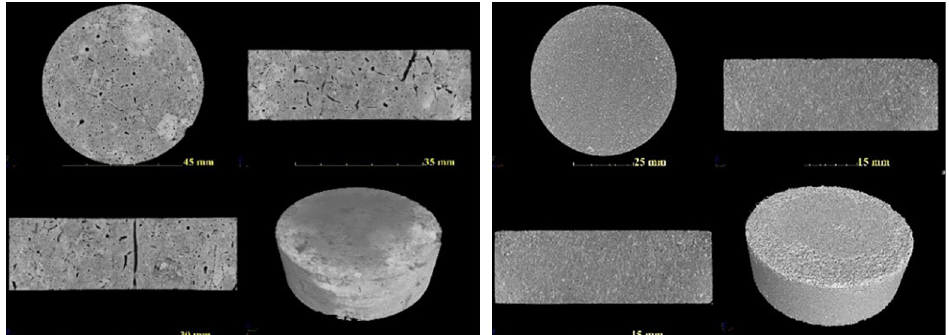
Fig 20. Three views and three-dimensional reconstruction of the ring cutter specimen. (A) Undisturbed loess. (B) Remolded loess.